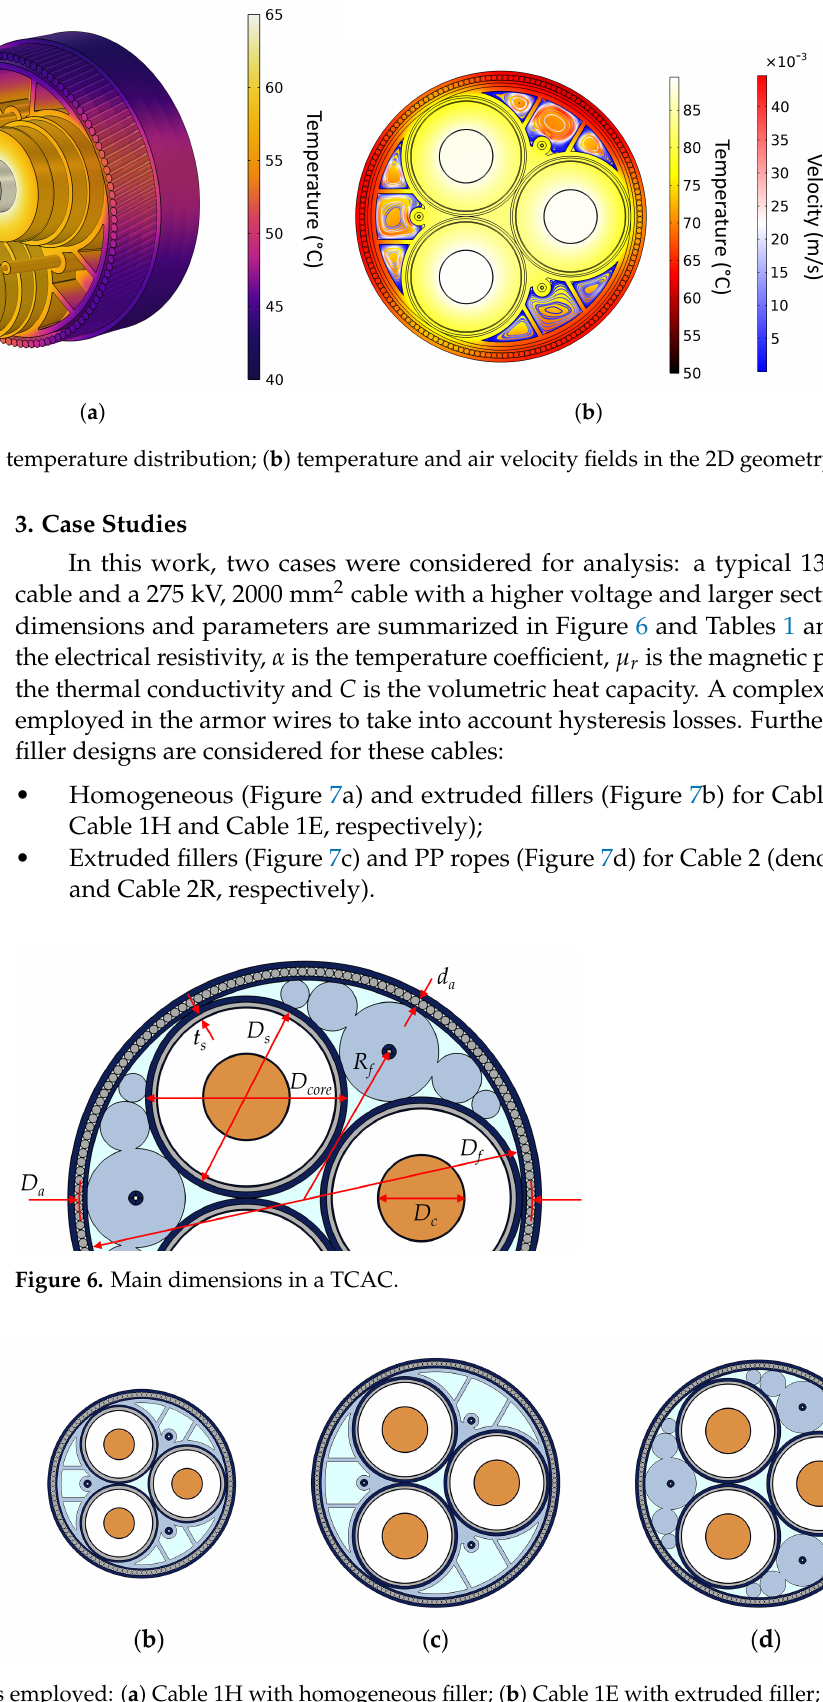
Figure 7. Cables and fillers employed: ( a ) Cable 1H with homogeneous filler; ( b ) Cable 1E with extruded filler; ( c ) Cable 2E with extruded filler; ( d ) Cable 2R with PP